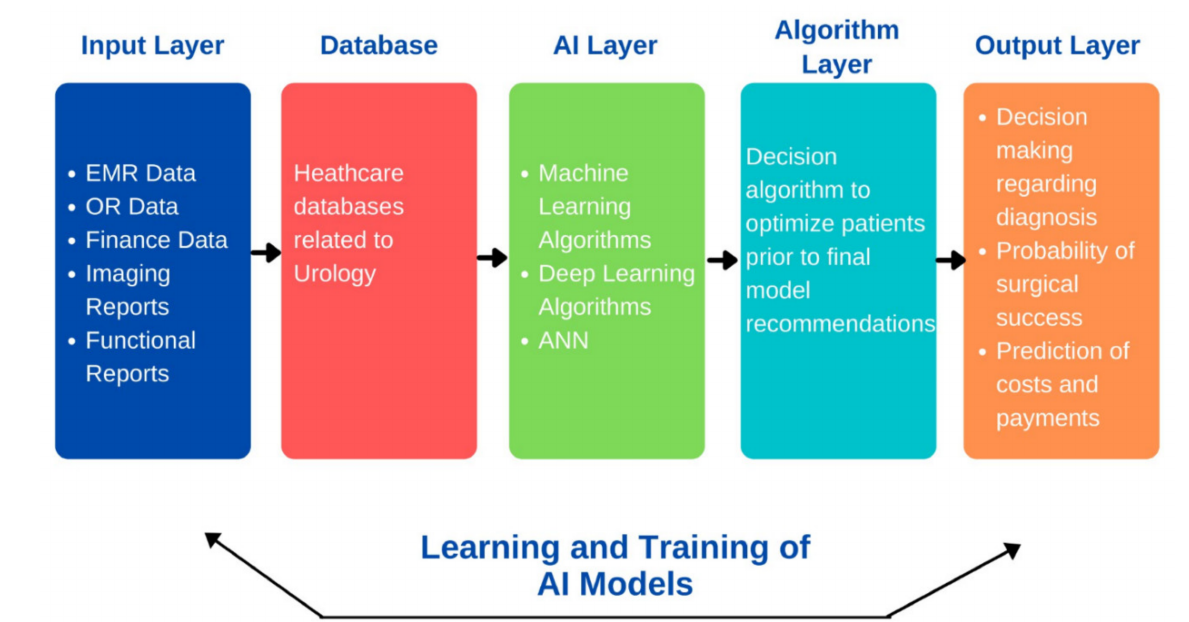
Figure 3. Artificial intelligence in decision making in patients with urological